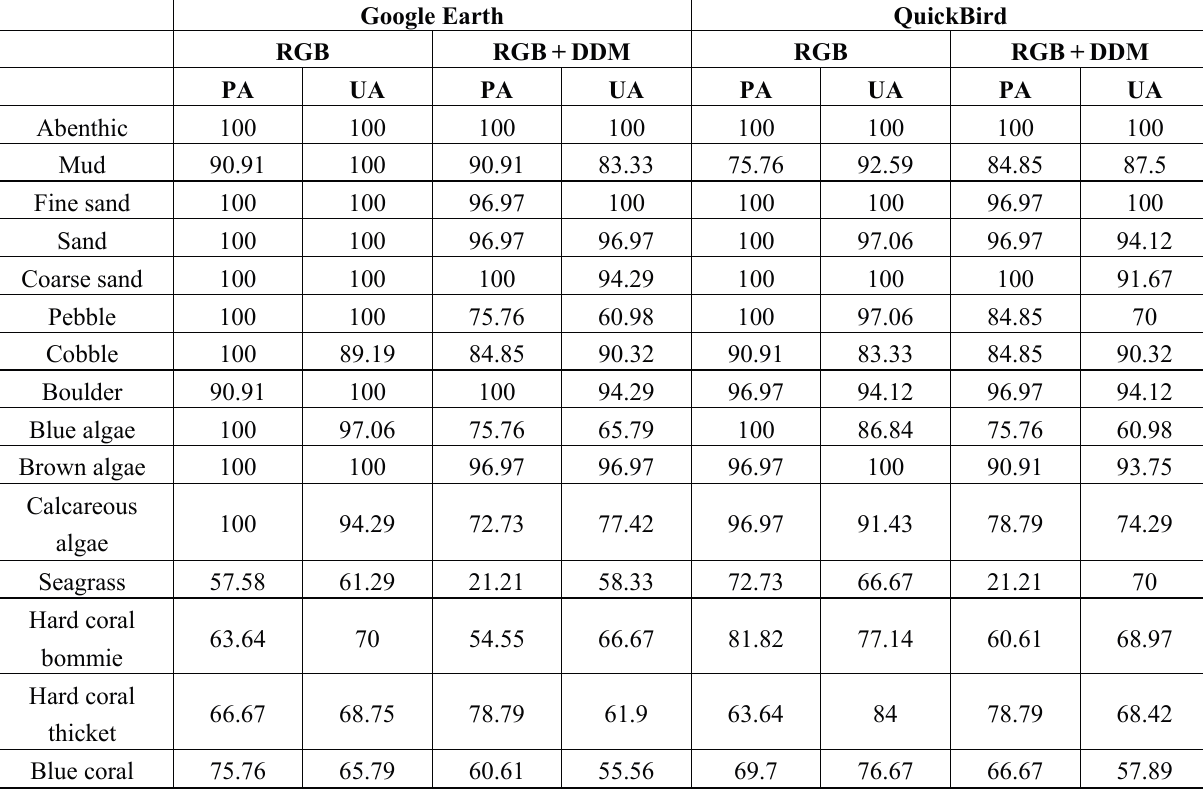
Table 3. Producer’s accuracy (PA) and user’s accuracy (UA) of the 15 seabed cover types with respect to the RGB Google Earth-derived very high resolution mosaic, QuickBird pansharpened datasets, and digital depth model